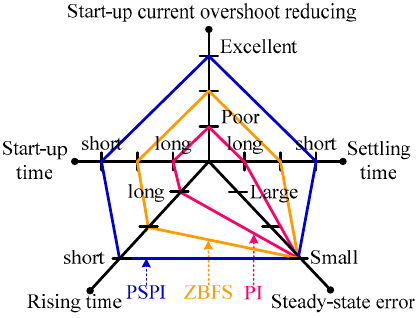
Figure 29. Performance indices for PSPI control, the ZBFS method, and PI control.